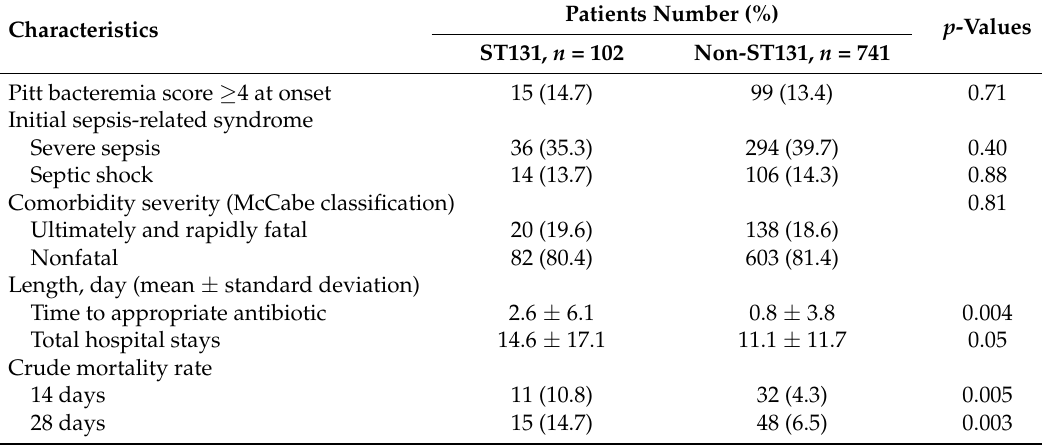
Table 2. Bacteremia and comorbidity severity and clinical outcomes of adults with community-onset monomicrobial Escherichia coli bacteremia due to sequence type 131 (ST131) and non-ST131 isolates.